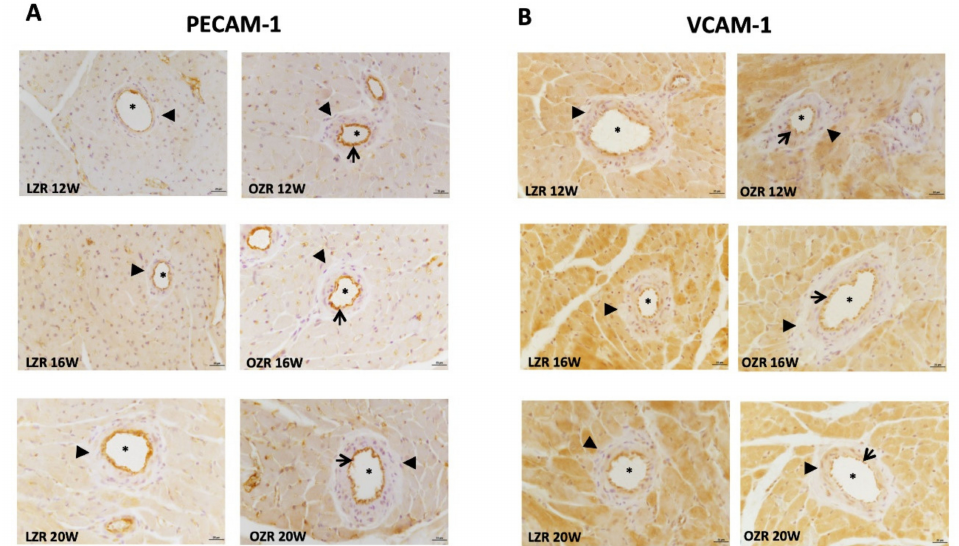
Figure 5. Inflammation. Sections of the heart of 12, 16, and 20 weeks old LZR and OZR processed for the immunohistochemistry of ( A ) platelet endothelial cell adhesion molecule-1 (PECAM-1); ( B ) vascular cell adhesion molecule-1 (VCAM-1), at the magnification 40 × . The immunoreaction is present in the endothelium (arrows). The lumen of vessels is indicated with the asterisks, while the tunica media is negative (arrow heads). Calibration bar 25 µ